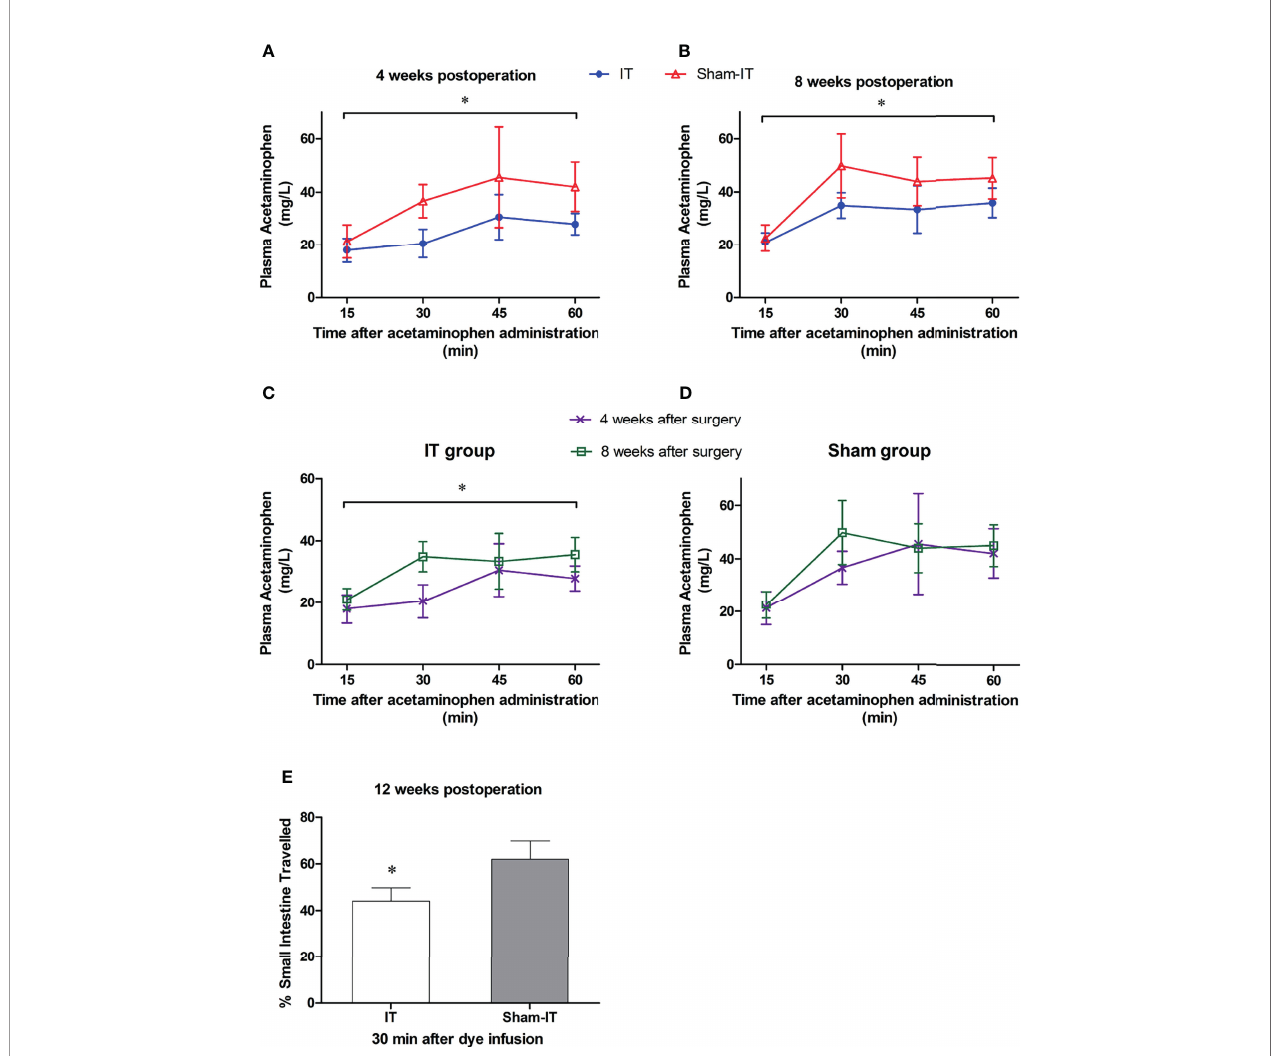
FIGURE 6 | The tests of GI motility after surgery. N = 6 in each group. * P < 0.05. (A) Plasma levels of acetaminophen at postoperative 4 weeks. The concentrations of acetaminophen were signi fi cantly lower in IT group than in sham group (Friedman test: p < 0.001). (B) Acetaminophen levels at postoperative 8 weeks. The concentration was signi fi cantly higher in sham than in IT group (repeated measures ANOVA: p = 0.010 IT vs. sham, p < 0.001 between time points, p = 0.121 of interaction). (C) Plasma levels of acetaminophen in IT group. The concentration of acetaminophen was higher at 8 weeks postoperatively than at 4 weeks (repeated measures ANOVA: p = 0.021 IT vs. sham, p < 0.001 between time points, p = 0.015 of interaction). (D) Plasma levels of acetaminophen in sham group. The levels did not differ over time (repeated measures ANOVA: p = 0.249 IT vs. sham, p < 0.001 between time points, p = 0.302 of interaction). (E) Intestinal transit (expressed as percentage of intestine travelled) at 30 min after toluidine blue O infusion. The dye travelled shorter in intestinal tract in IT compared to sham group ( t -test, p =